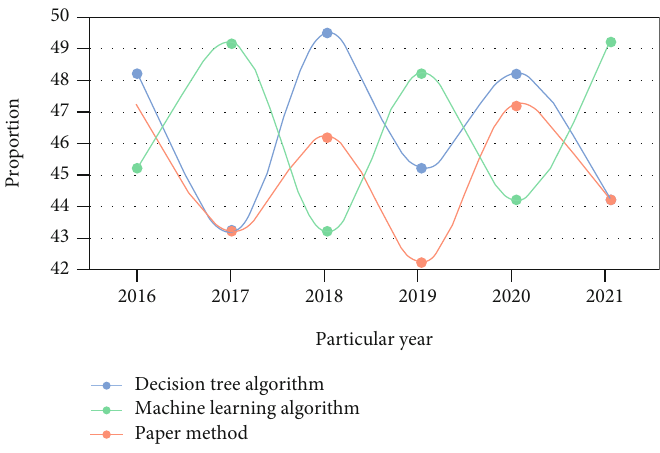
Figure 6: Average power outage time of plant